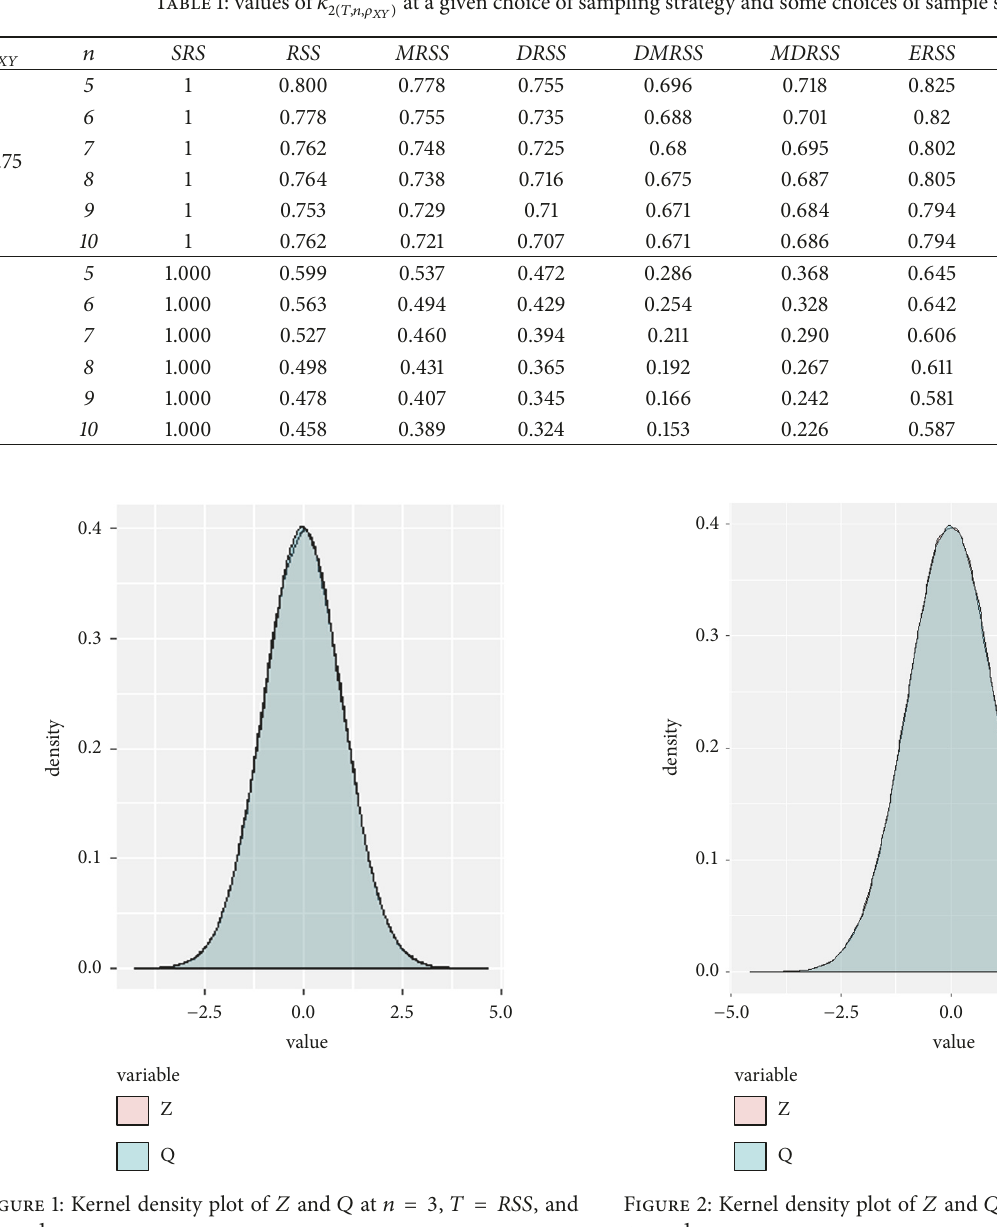
Table 1: values of 𝑘 2(𝑇,𝑛,𝜌 at a given choice of sampling strategy and some choices of sample size 𝑛 . 𝑋𝑌 )